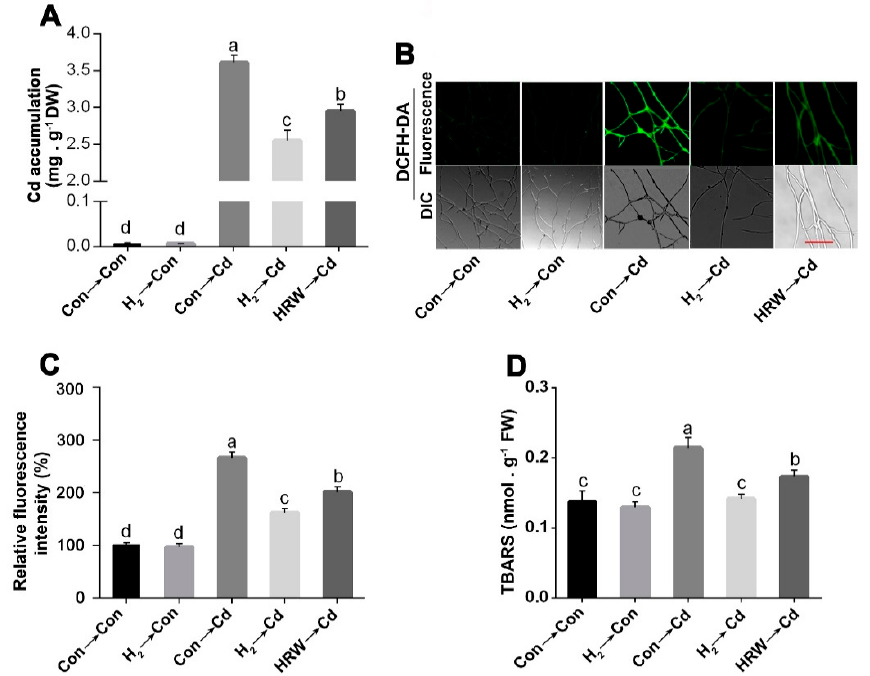
Figure 2. H 2 -fumigation pre-treatment reduced Cd accumulation and decreased ROS and TBARS contents in G. lucidum . Mycelia were cultured on solid CYM media for 2 days. Then, on the 3rd day, mycelia were pre-treated with 3% H 2 fumigation, 50% HRW for 24 h, or not treated with either hydrogen form (control). On the 4th day, 6-mm-diameter mycelial discs from these treatments were transferred to solid CYM or 1.75 mM CdCl 2 -containing solid CYM, each with or without inserted glass coverslips then grown for 5 days. Afterward, samples from the plates without coverslips were immediately used for Cd content analysis ( A ). Coverslips with mycelia on their surface were loaded with DCFH − DA, and then the ROS fluorescence intensities were analyzed via confocal laser microscopy ( B ). Scale bar = 100 µ m. DIC, differential interference contrast. Respective fluorescence intensities were measured ( C ). Mycelia were also sampled for TBARS analysis ( D ). Mycelia without chemicals were used as a control for each analysis (Con → Con). Bars with different letters are significantly different at p < 0.05 according to one-way ANOVA with multiple comparison using Tukey’s